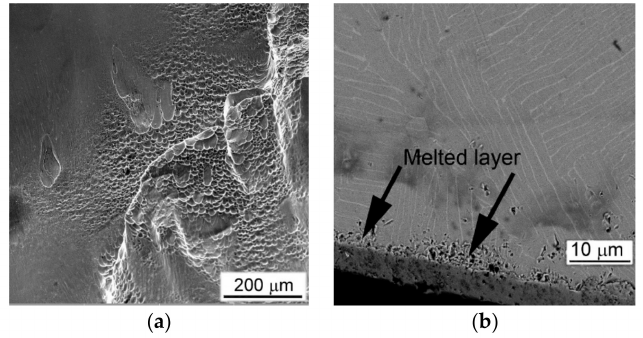
Figure 14. Microstructure of the cracked Ti64LM specimen after SHPB tested at the strain rate of